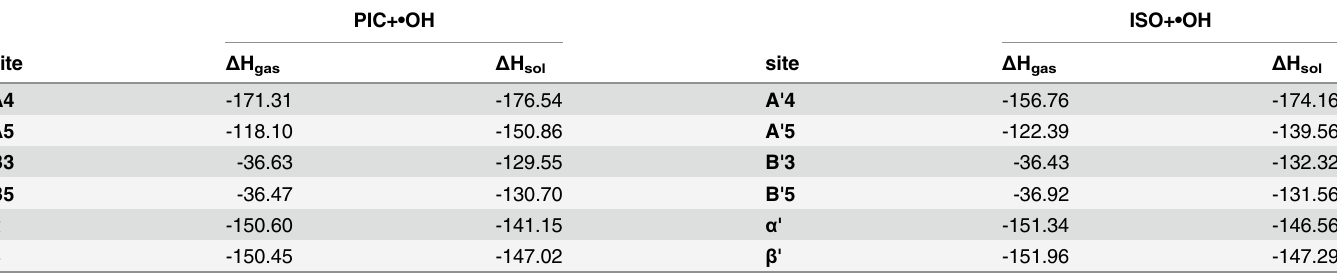
Table 2. The reaction enthalpies at 298K for reactions of PIC and ISO with (cid:129) OH in the gas phase and water (in